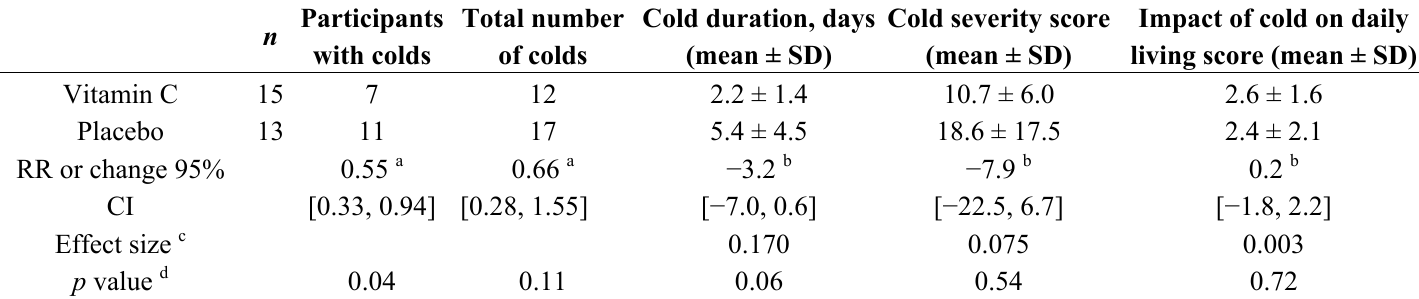
Table 3. Cold outcomes in participants ingesting 1000 mg vitamin C versus placebo daily for eight weeks